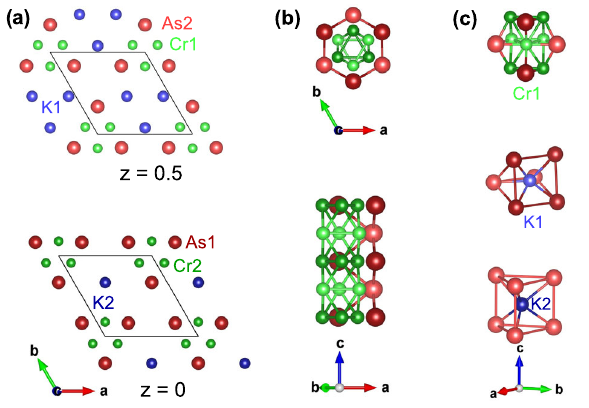
FIG. 2. Crystal structure of K 2 Cr 3 As 3 . (a) The constituted atoms locate in the two crystalline planes with z ¼ 0 and z ¼ 0 . 5 . (b) The structure of ½ð Cr 3 As 3 Þ 2 − (cid:2) ∞ double-walled subnanotubes (top: top view; bottom: side view with removal of the outer wall in the left front). (c) Chemical bonding of Cr1 (top), K1 (middle), and K2 (bottom).